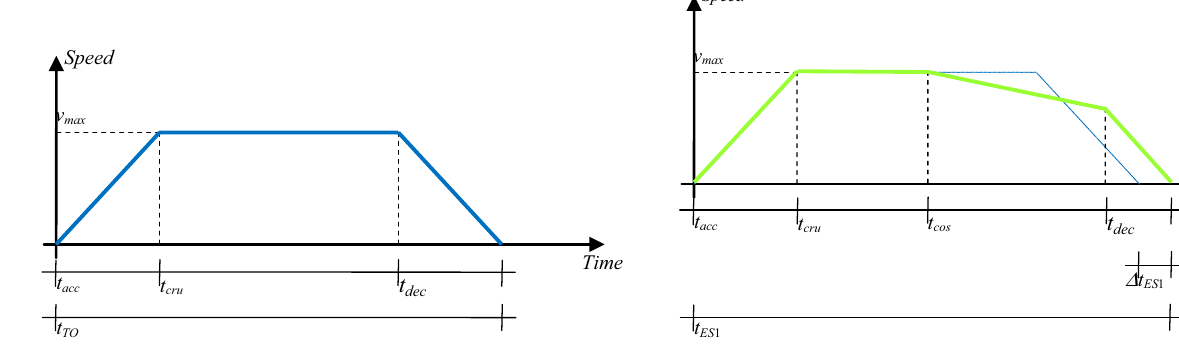
Fig. 14 Speed profile in the case of a Time Optimal (TO) strategy Fig. 15 Speed profile in the case of energy-saving (ES) strategy